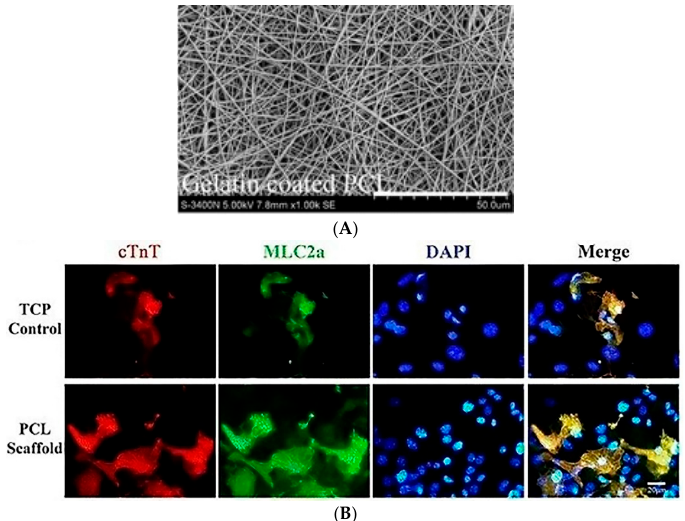
Figure 4. Representative image of poly-( ε -caprolactone) (PCL) nanofibrous scaffold coated with gelatin (upper panel, ( A )) used to promote CM differentiation of miPSCs. Gelatin-coated PCL scaffolds support miPSC differentiation into CMs, increasing the expression of cTnT and Mlc2a after 15 days culture time (lower panels, ( B )). Reproduced with permission from Chen et al. [96].